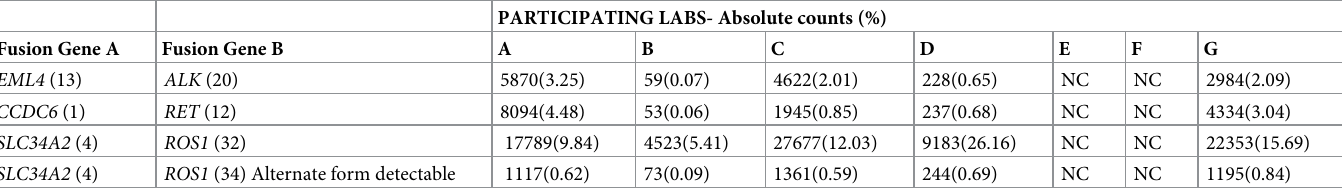
Table 13. Detection of fusions from the RNA control material across the ring study laboratories. PARTICIPATING LABS- Absolute counts